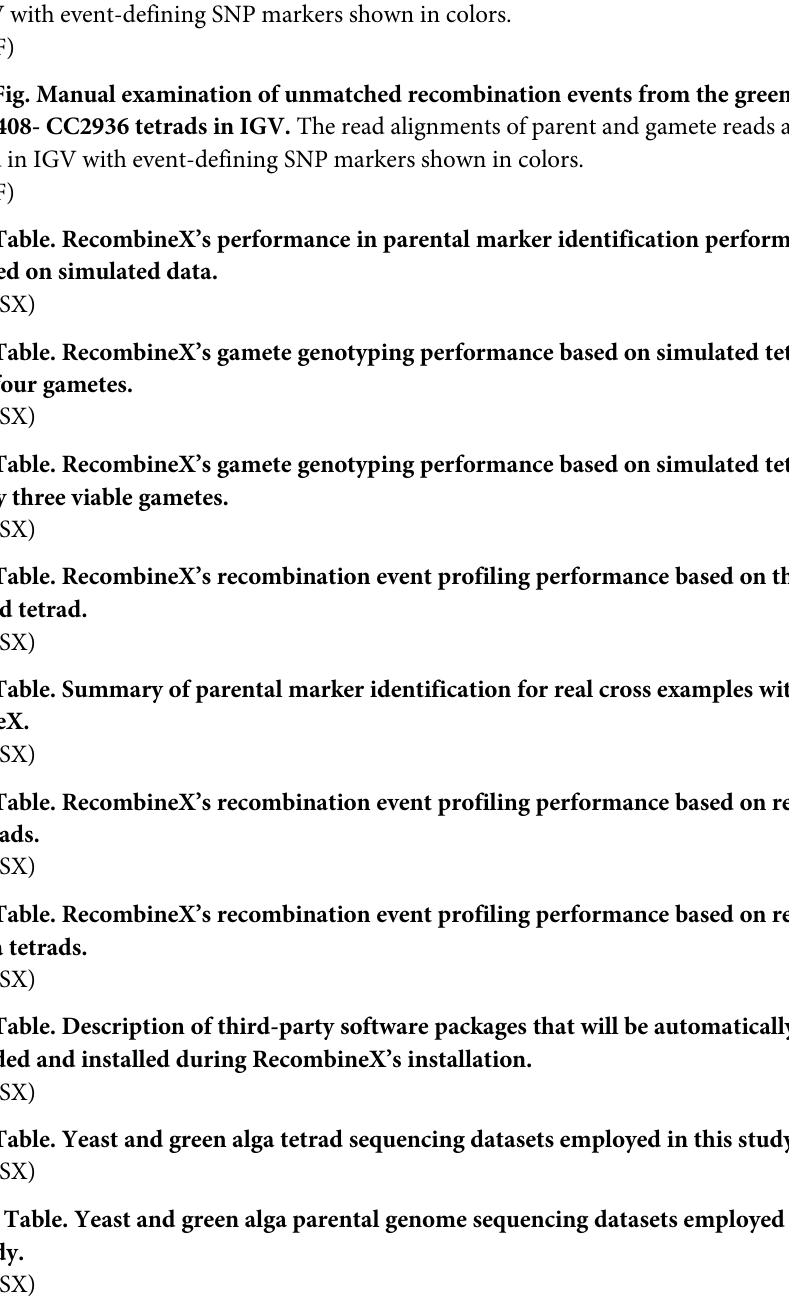
S7 Fig. Manual examination of unmatched recombination events from the yeast S288C-SK1 tetrads in IGV. The read alignments of parent and gamete reads are visualized in IGV with event-defining SNP markers shown in colors. S8 Fig. Manual examination of unmatched recombination events from the green alga CC408- CC2936 tetrads in IGV. The read alignments of parent and gamete reads are visual- ized in IGV with event-defining SNP markers shown in colors. S1 Table. RecombineX’s performance in parental marker identification performance based on simulated data. S2 Table. RecombineX’s gamete genotyping performance based on simulated tetrads with all four gametes. S3 Table. RecombineX’s gamete genotyping performance based on simulated tetrads with only three viable gametes. S4 Table. RecombineX’s recombination event profiling performance based on the simu- lated tetrad. S5 Table. Summary of parental marker identification for real cross examples with Recom- bineX. S6 Table. RecombineX’s recombination event profiling performance based on real yeast tetrads. S7 Table. RecombineX’s recombination event profiling performance based on real green alga tetrads. S8 Table. Description of third-party software packages that will be automatically down- loaded and installed during RecombineX’s installation. S9 Table. Yeast and green alga tetrad sequencing datasets employed in this study. (XLSX) S10 Table. Yeast and green alga parental genome sequencing datasets employed in this